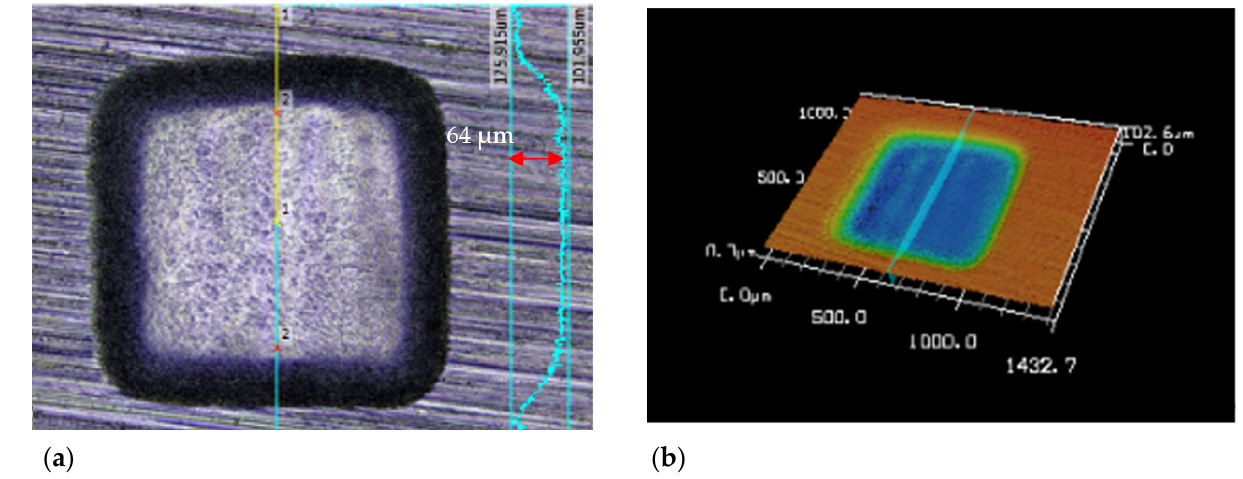
Figure 16. The morphology and profile of a square cavity were conducted by ECM milling. ( a ) The scanning line reveals the depth of cavity is 64 μ m, ( b ) the 3D profile of the cavity.